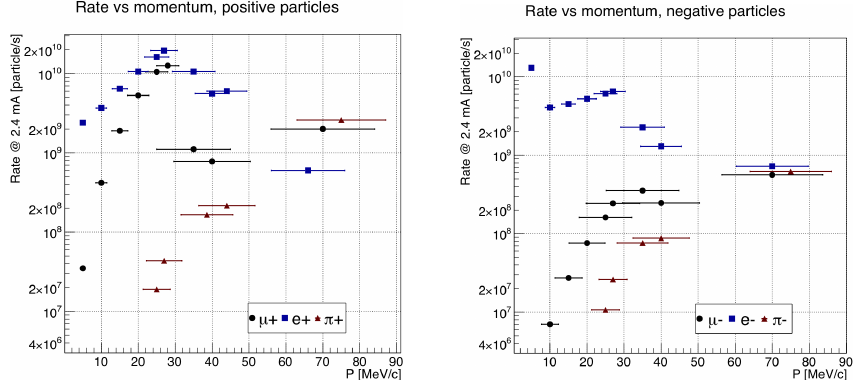
Figure 11. Momentum spectrum of positive (top) and negative (bottom) particles as delivered by MUH2 at the entrance of the experimental area for di ff erent momentum settings at a proton current of 2 . 4mA [10]. The error bars show the standard deviation of the momentum